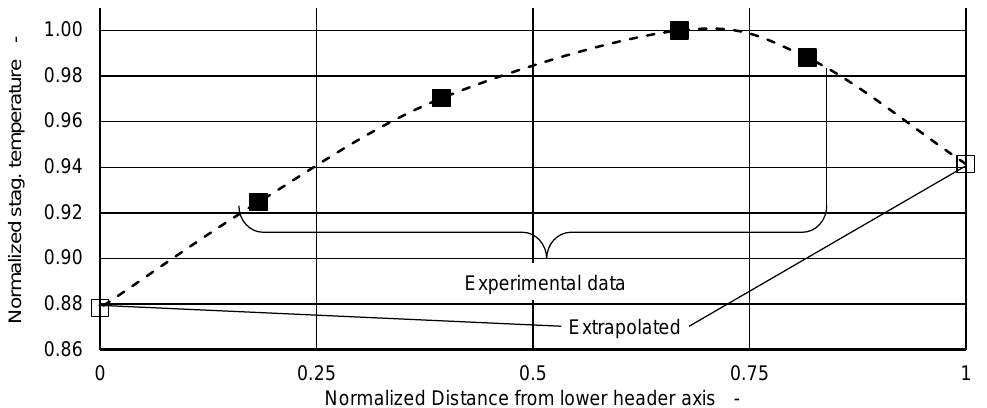
Figure 5. Normalized temperature distribution during dry stagnation, as a function of the distance from the lower header axis. The black markers indicate values measured.